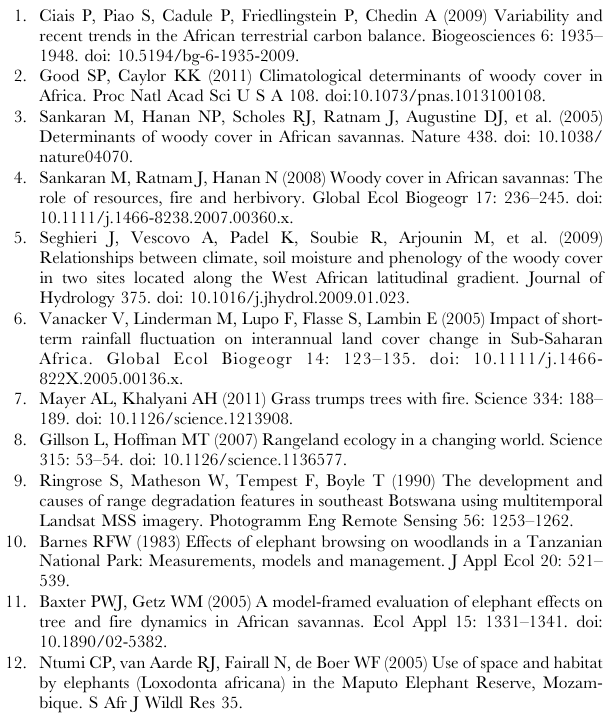
Table S1 Initial dimensional reduction of candidate explanatory variables. Table S2 Dimensional reduction of Normalized Differ- ence Vegetation Index (NDVI). Table S3 Spatial distribution of weighting coefficients for model